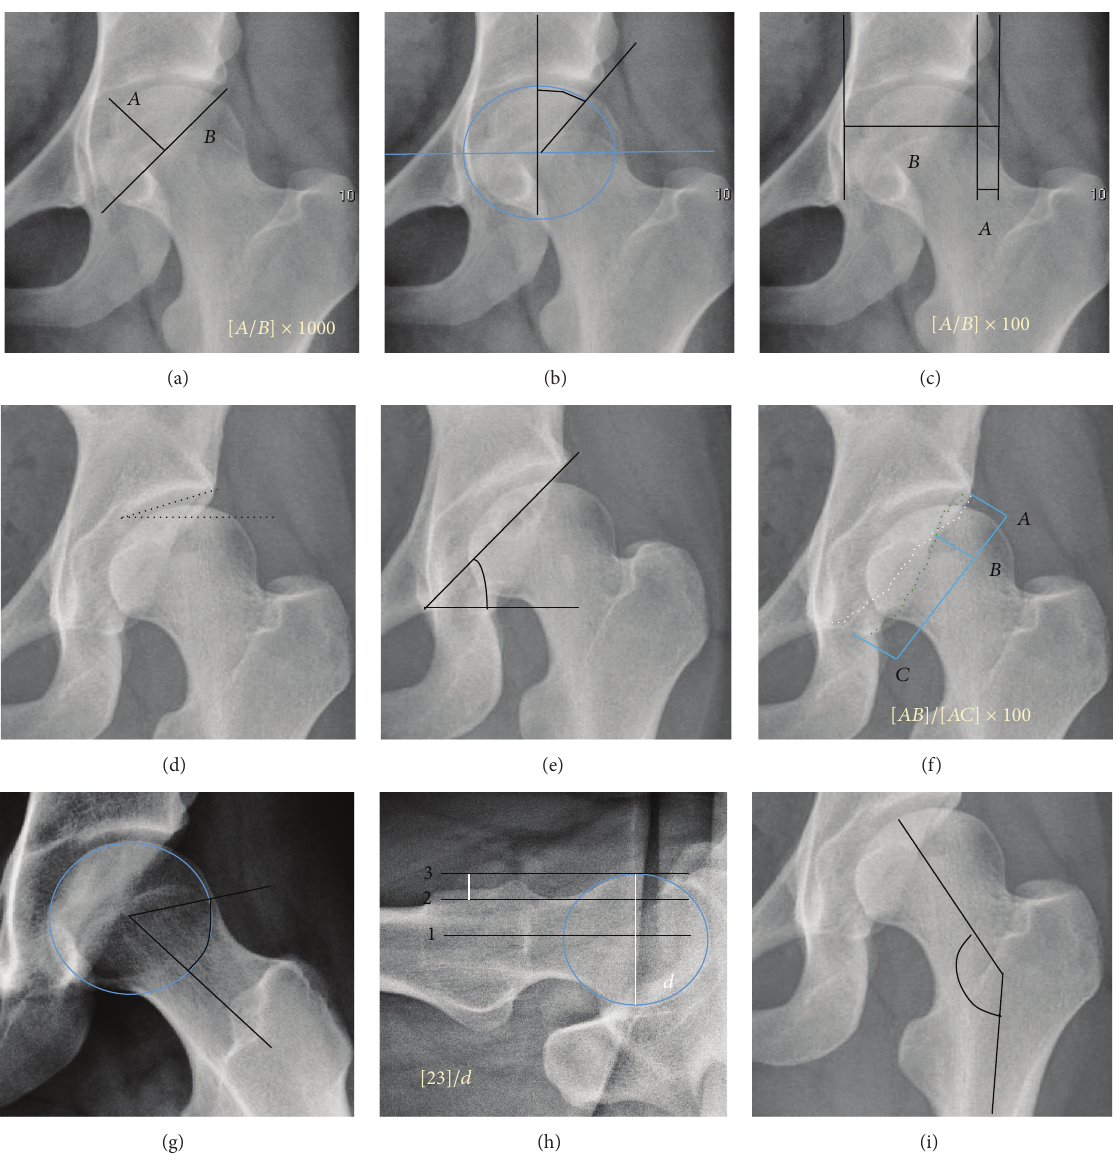
Figure 6: (a) Acetabular depth ratio. (b) Center-edge angle of Wiberg. (c) Femoral extrusion index. (d) T¨onnis angle. (e) Sharp angle. (f) Crossing ratio. (g) Alpha angle measured in 45 ∘ Dunn view. (h) Offset percentage measured in cross-lateral view. (i) Cervical diaphyseal angle.